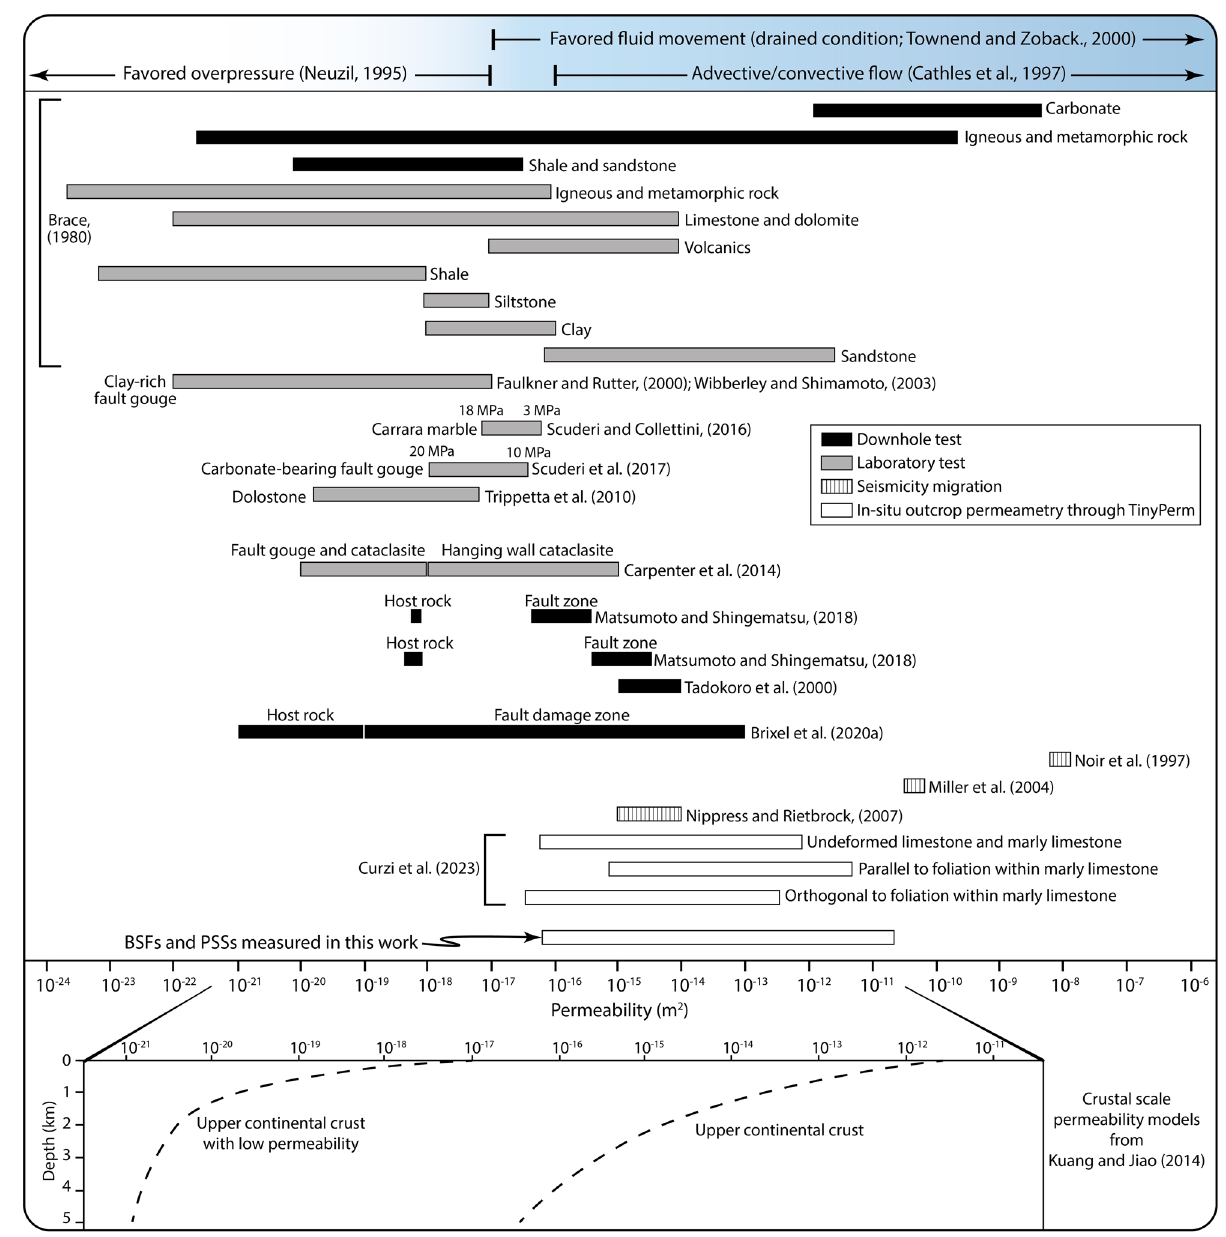
Figure 9. Permeability range for different rocks, fault rocks, and crustal volumes as constrained by downhole and laboratory tests, seismicity migration, and in-situ outcrop permeametry. Permeability values as predicted by upper crustal scale permeability models are also shown by the black dotted